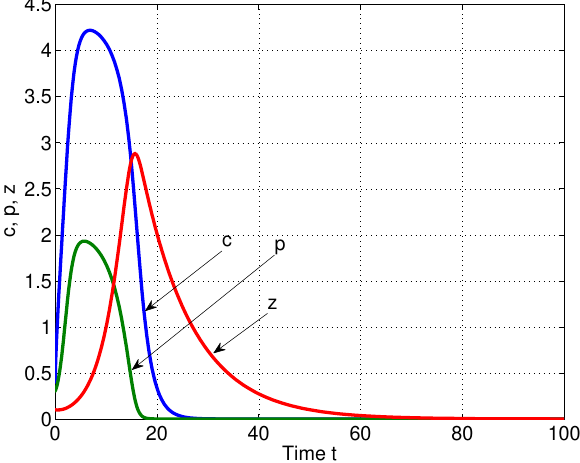
Figure 9. Interior equilibrium of the plankton–oxygen model studied by Sekerci and Petrovskii [3] does not exist under the parametric set: { A = 10, c 0 = 1, δ = 1, c 2 = 1, m = 0.5, B = 1.8, c 1 = 1.0, γ = 0.7, σ = 0.1, ν = 0.01, µ = 0.5, h = 1.2, s = 1.0, η = 0.7, c 4 = 1, and c 3 = 1 } . Initial conditions: c ( 0 ) = 0.385, p ( 0 ) = 0.3, z ( 0 ) = 0.1.